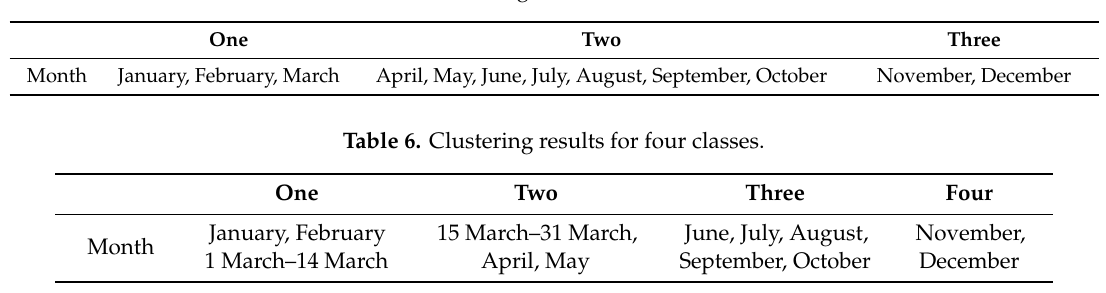
Table 5. Clustering results for three classes.